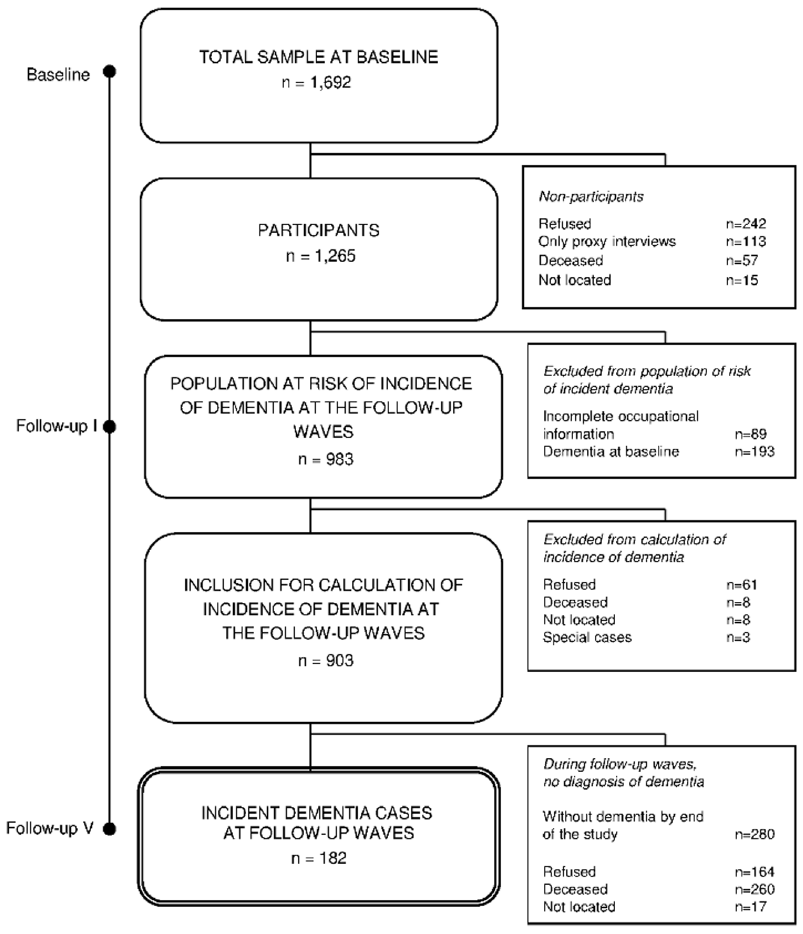
Figure 1. Sampling Frame of the Participants.